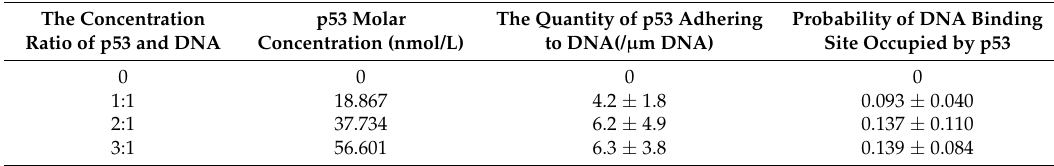
Table 2. Mean quantities and probability of p53 adhering to 1 µ m 5000 bp DNA, corresponding to the concentration ratios of p53 and 5000 bp